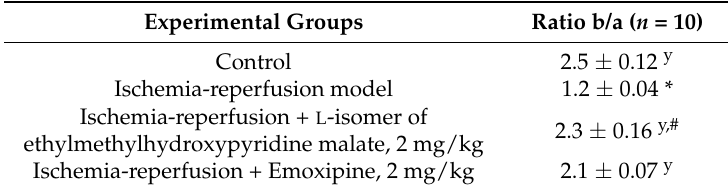
Table 2. Influence of L -isomer of ethylmethylhydroxypyridine malate and Emoxipine on the value of the b/a coefficient when correcting retinal ischemia-reperfusion (M ± m; n = 10),